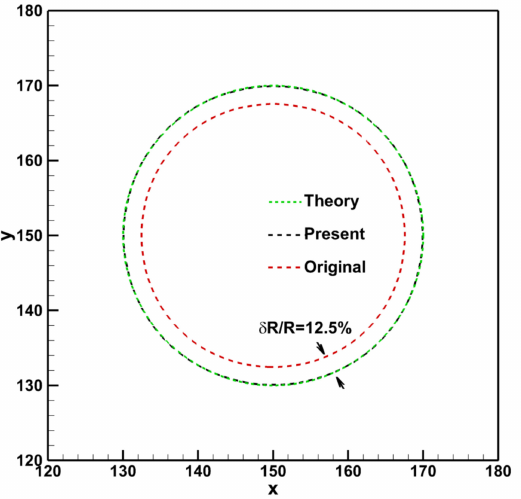
Figure 6. The final interface shapes for the static bubble of R = 20 at σ = 0.005.